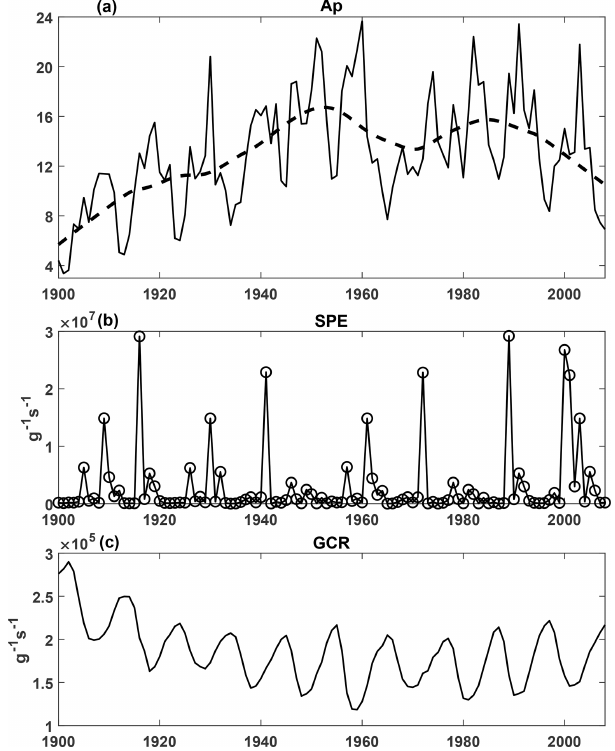
Figure 2. (a) Annual time series of geomagnetic activity index Ap (solid line) and 31-year smooth trend (dotted line). (b) Annual time series of SPEs (ion pair production rate at 1hPa, 70–90 ◦ S). (c) An- nual time series of GCR (ion pair production rate at 100hPa, 70– 90 ◦